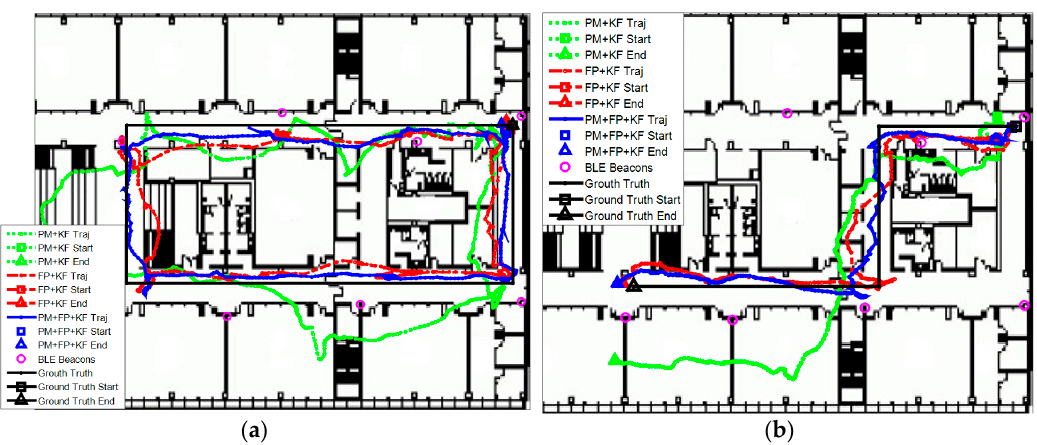
Figure 15. Estimated trajectories with sparse deployment of BLE beacons using the proposed algorithm, PM + EKF and FP + EKF: ( a ) Trajectory I; and ( b ) Trajectory II.